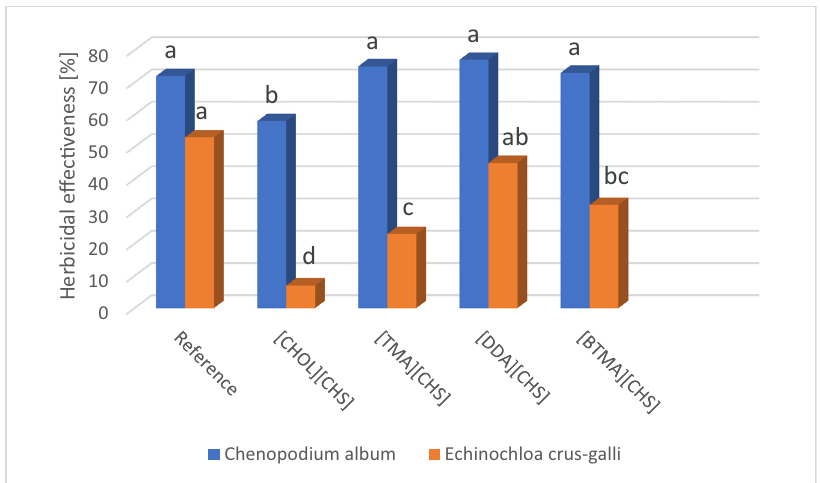
Figure 5: Herbicidal e ff ectiveness of the tested HILs ( 1 – 4 ) .